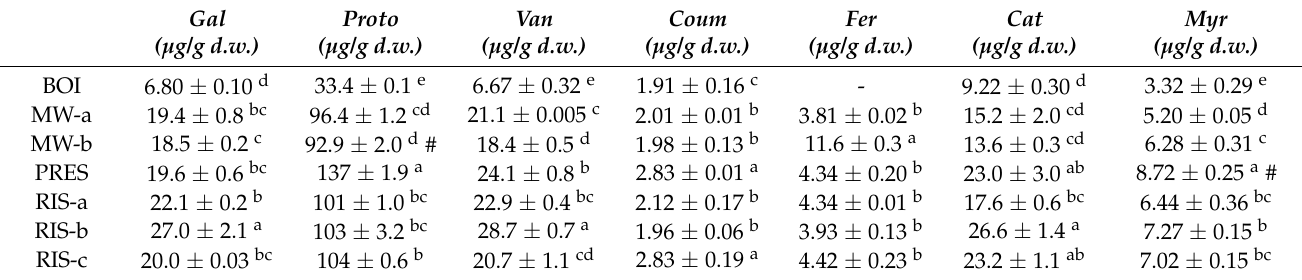
Table 5. Phenolic acids and flavonoids ( µ g/g d.w.) identified in cooked black rice; the results are expressed as mean ± stan- dard deviation. Values with different letters in the same column are significantly different ( p < 0.05). Values marked with # are not significantly different from the corresponding ones determined in uncooked rice. Gal, gallic acid; Proto, protocatechuic acid; Van, vanillic acid; Coum, coumaric acid; Fer, ferulic acid; Cat, catechin; Myr, myricetin. Gal Proto Van Coum Fer Cat Myr ( µ g/g d.w.) ( µ g/g d.w.) ( µ g/g d.w.) ( µ g/g d.w.) ( µ g/g d.w.) ( µ g/g d.w.) ( µ g/g